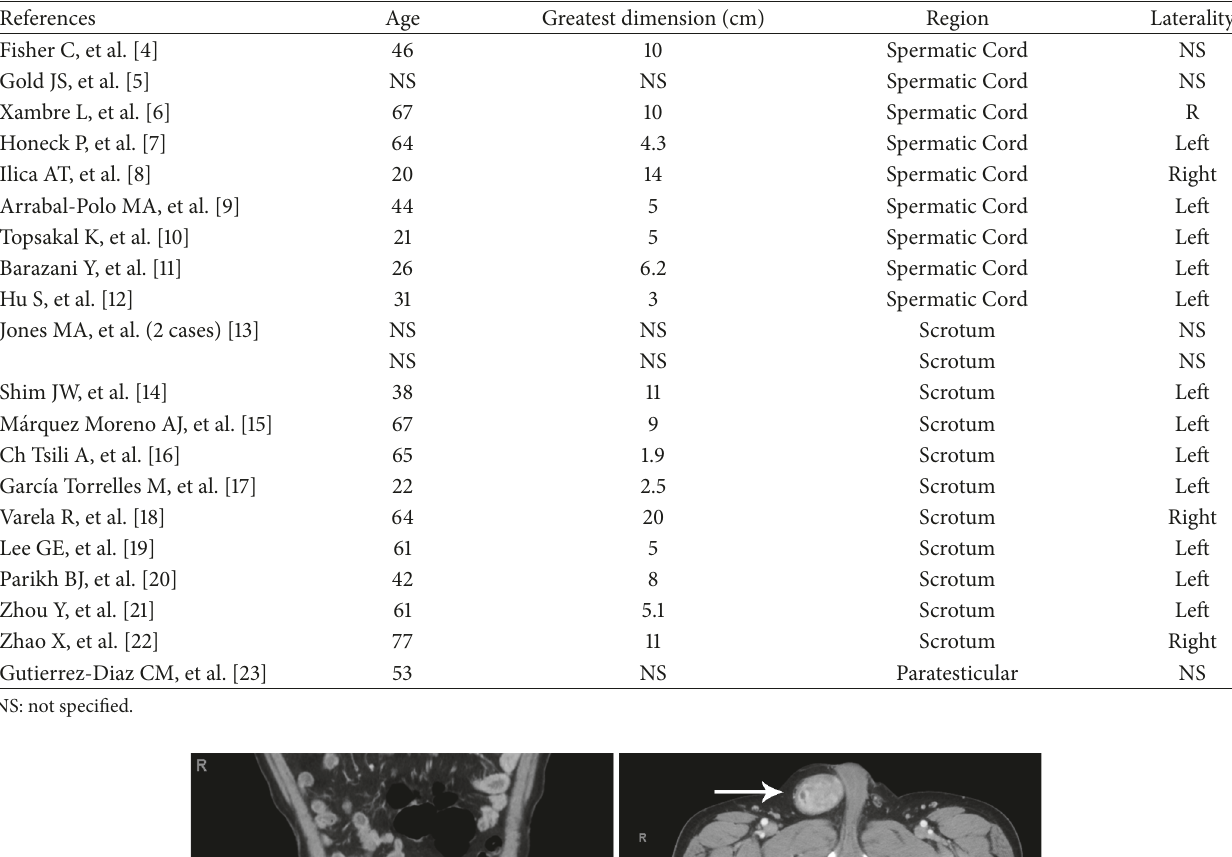
Table 1: Summary of cases.